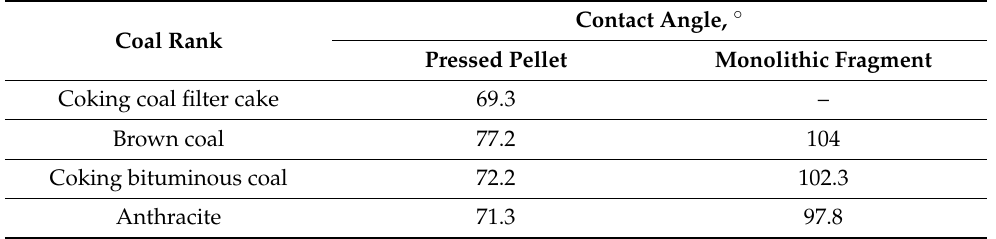
Table 2. Contact angles of